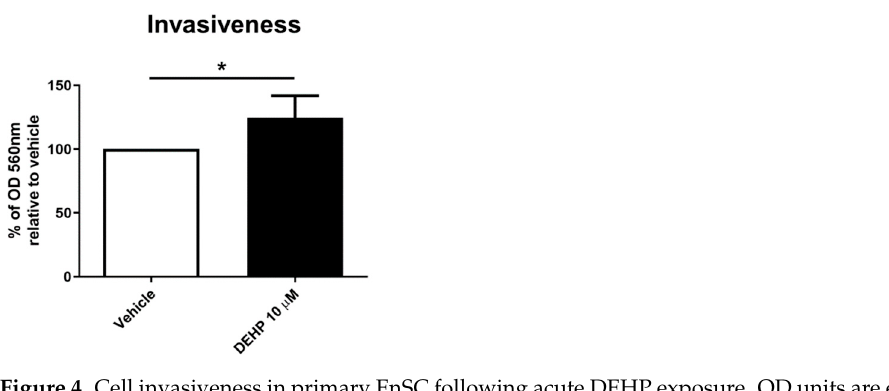
Figure 4. Cell invasiveness in primary EnSC following acute DEHP exposure. OD units are expressed as the percentage of migrating cells compared with the vehicle and represent the percentage ± SD for six different samples (* p < 0.05).